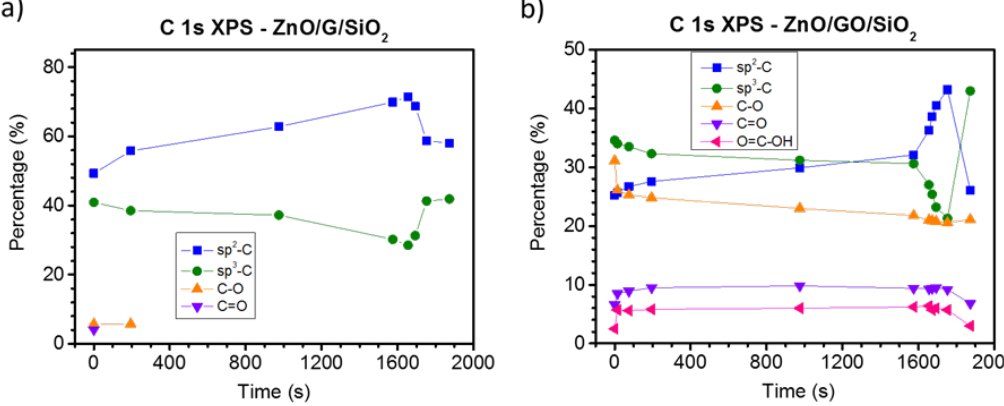
Figure 6. Relative intensities of the XPS C 1s contributions used for the fitting of the spectra in Figure 5 as a function of evaporation time for ZnO on ( a ) G/SiO 2 and ( b ) GO/SiO 2 .